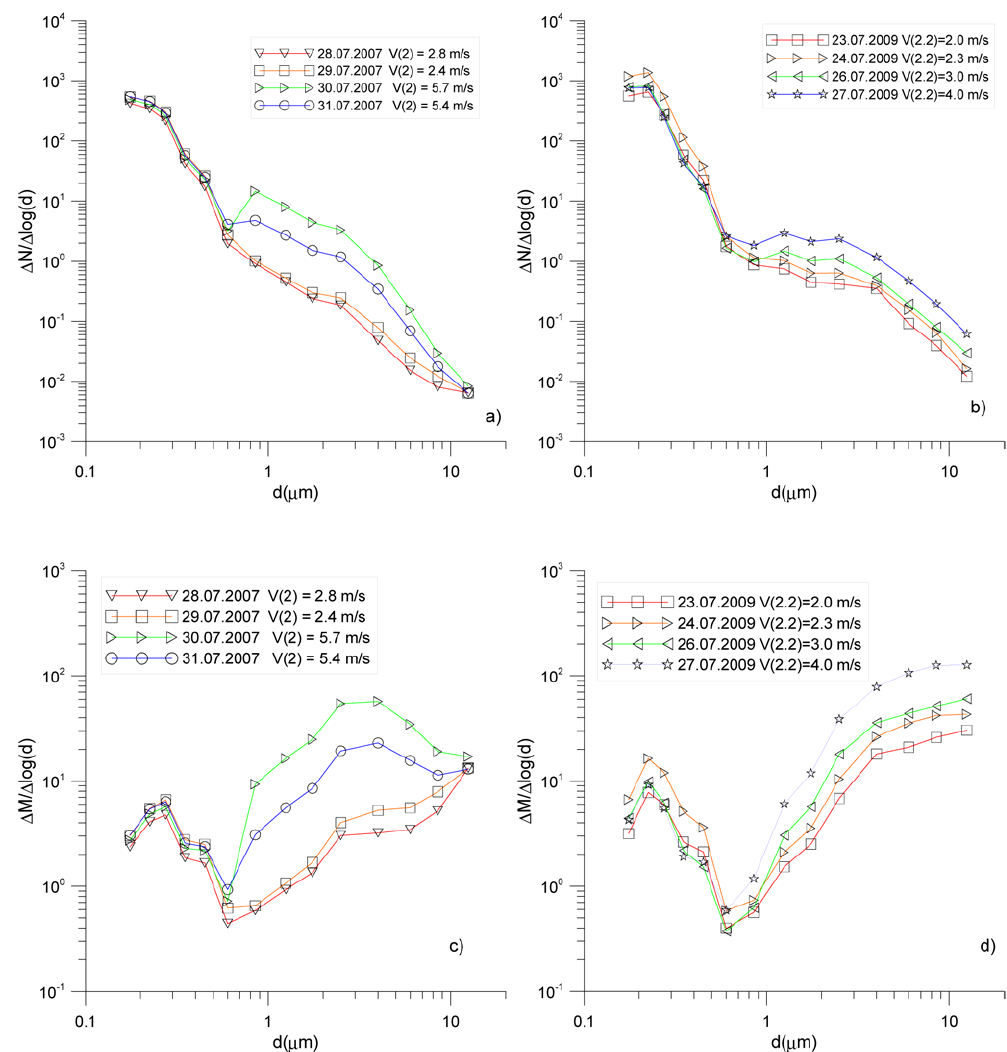
Fig. 2. Daytime mean distributions of particles at a height of 2m (a) for 2007, (b) for 2009; inserts: the daytime-mean horizontal velocity at 2m (for 2007) and 2.2m (for 2009). Daytime-mean mass distribution of particles at 2m (c) for 2007, (d) for 2009); inserts: the daytime- averaged horizontal velocity at 2m (for 2007) and 2.2m (for 2009).